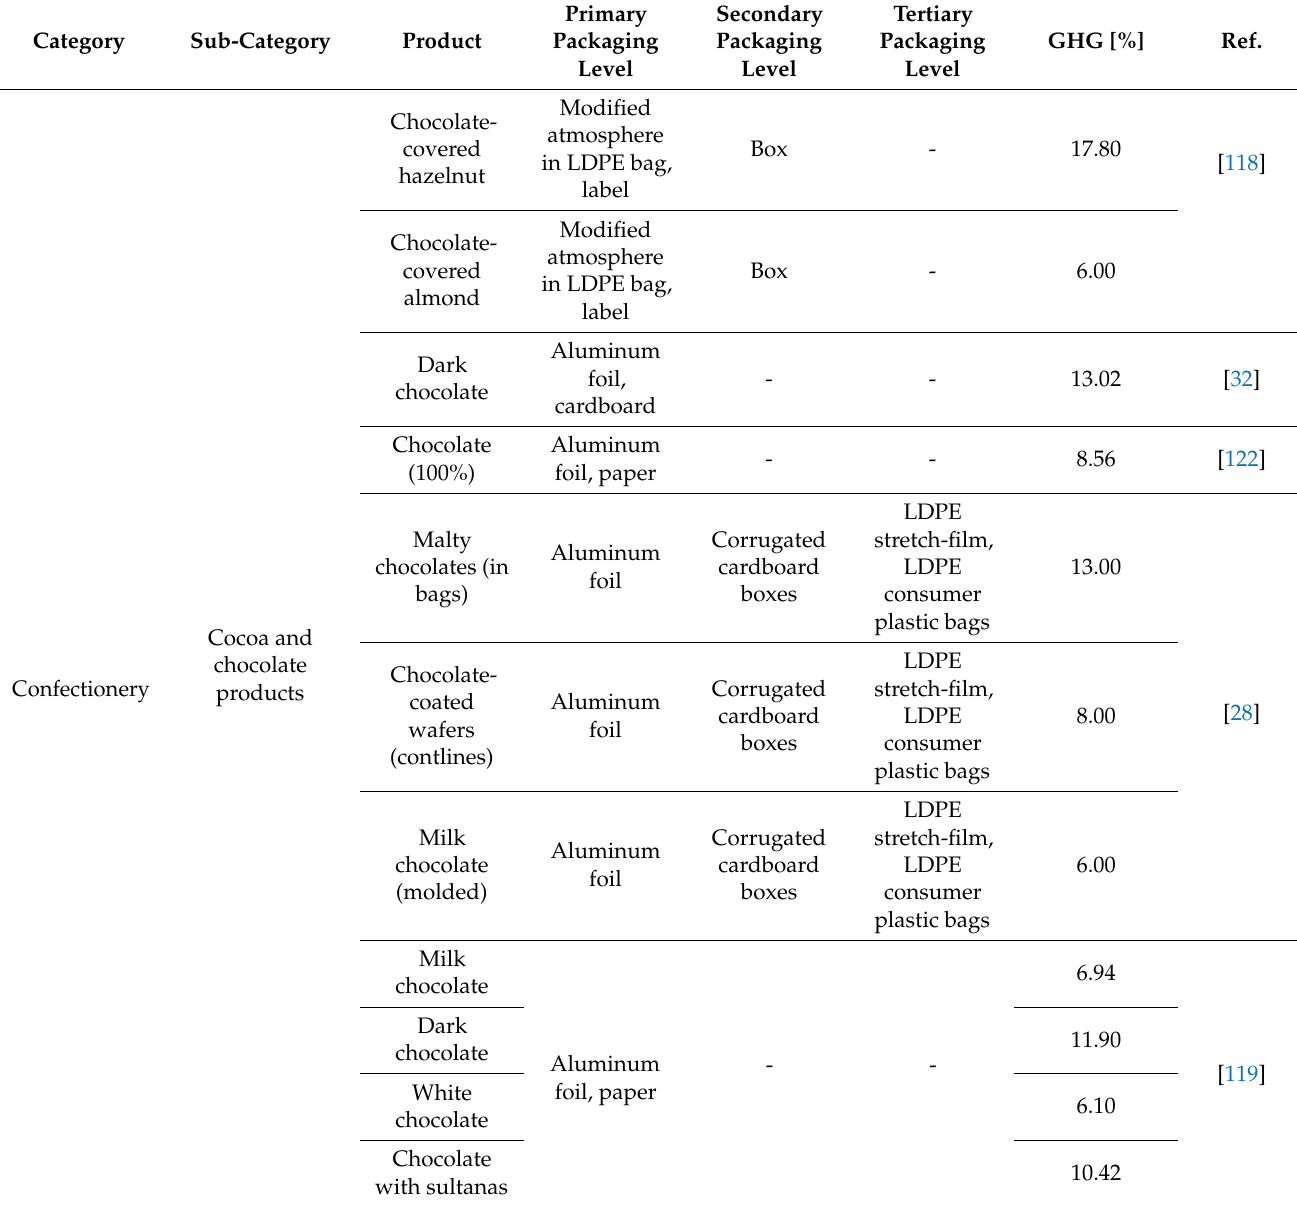
Table 2. Reviewed cereal and confectionary life cycle assessment (LCA) studies: information on packaging and its percentage share of total greenhouse gas (GHG)